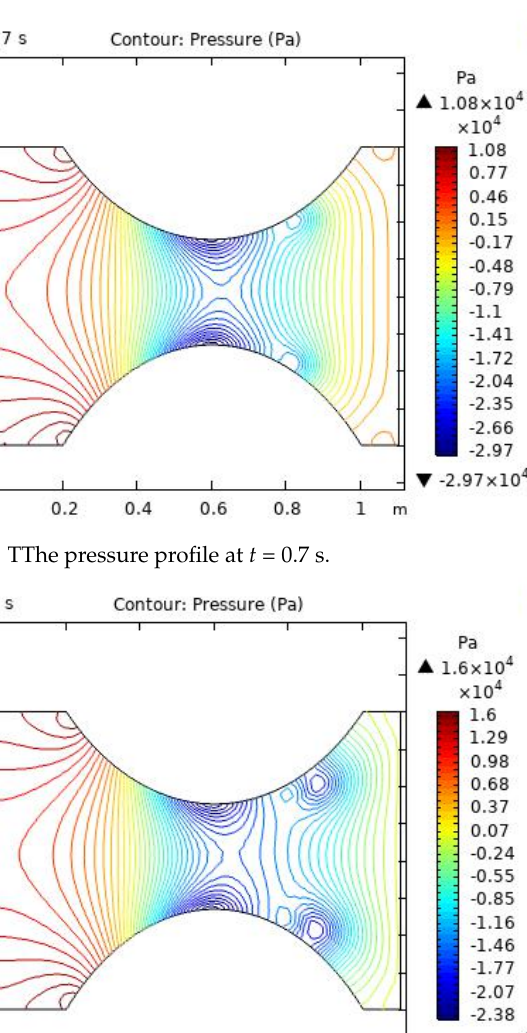
Figure-14. The pressure profile at t = 0.1 s. Figure 14. The pressure profile at t = 0.1 s.